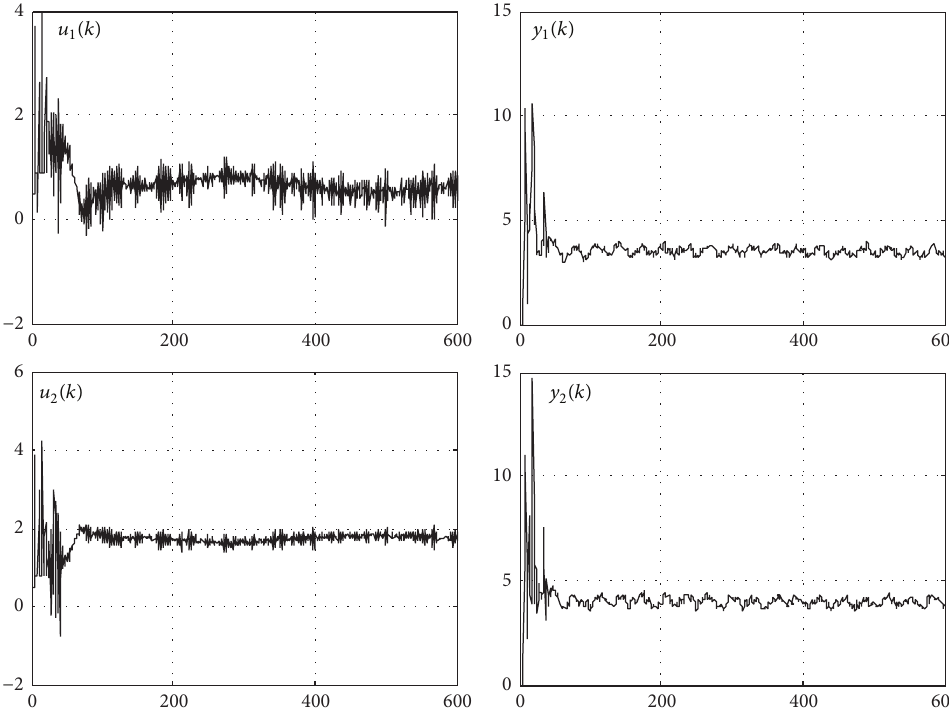
Figure 6: Evolution curves of the control laws 𝑢 1 (𝑘) and 𝑢 2 (𝑘) and the outputs 𝑦 1 (𝑘) and 𝑦 2 (𝑘) of the system.